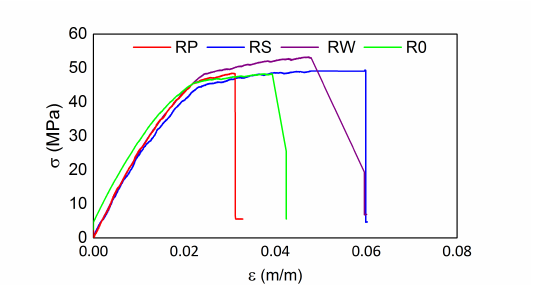
Figure 17. Tensile test results for M3 X samples after exposition on sub-zero temperatures.